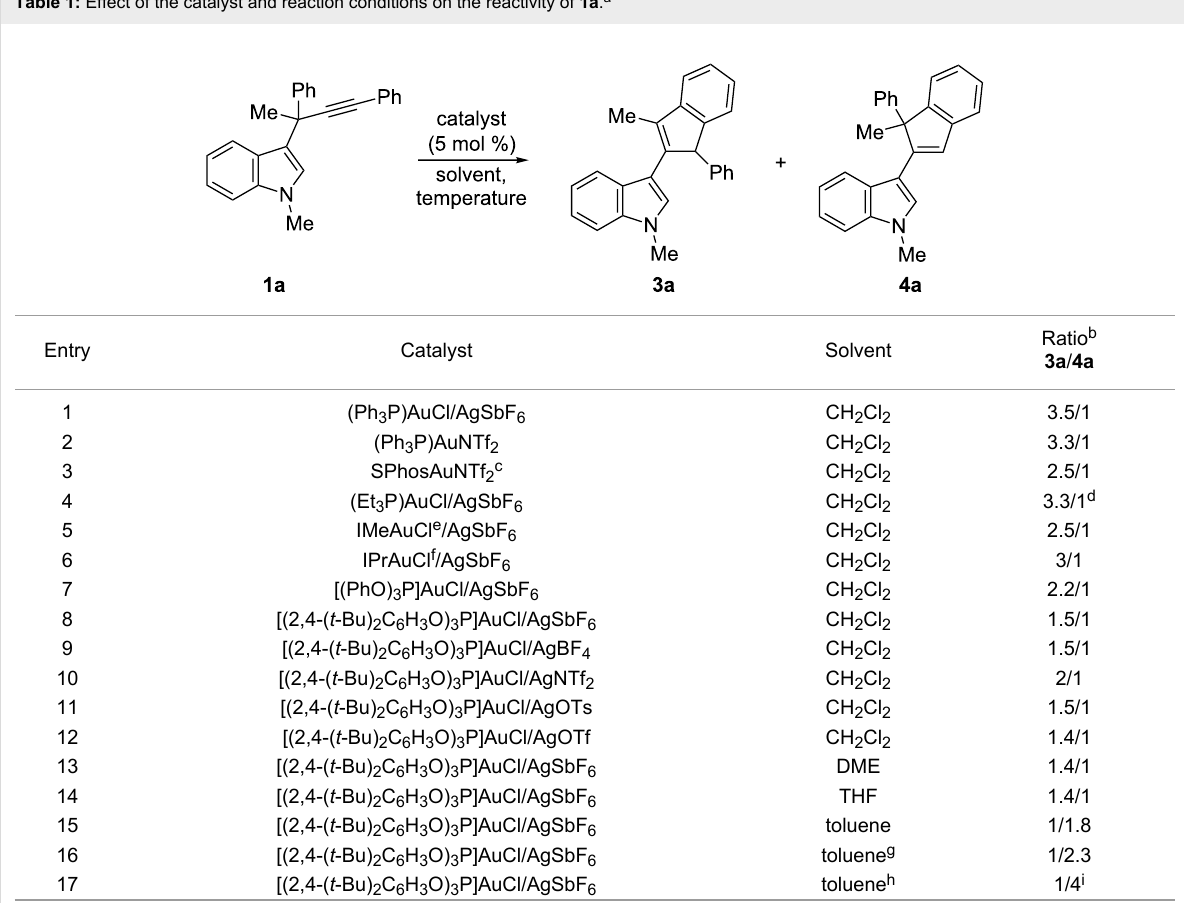
Table 1: Effect of the catalyst and reaction conditions on the reactivity of 1a . a